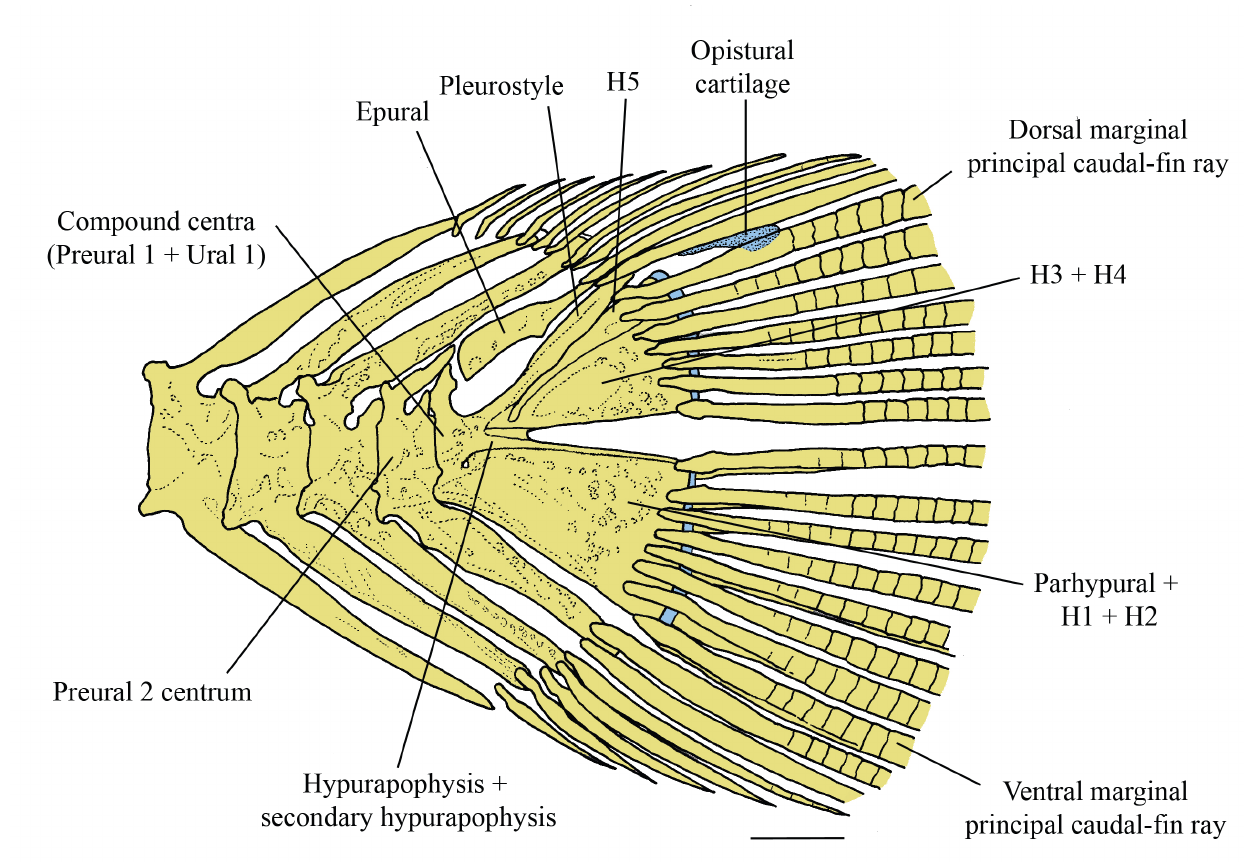
FIGURE 3 | Rhyacoglanis varii caudal-fin skeleton, paratype, MZUEL 6039, 53.5 mm SL. Bones in yellow ocher and cartilage in blue. H1 to H5 = hypurals 1 to 5. Scale bar = 1.0